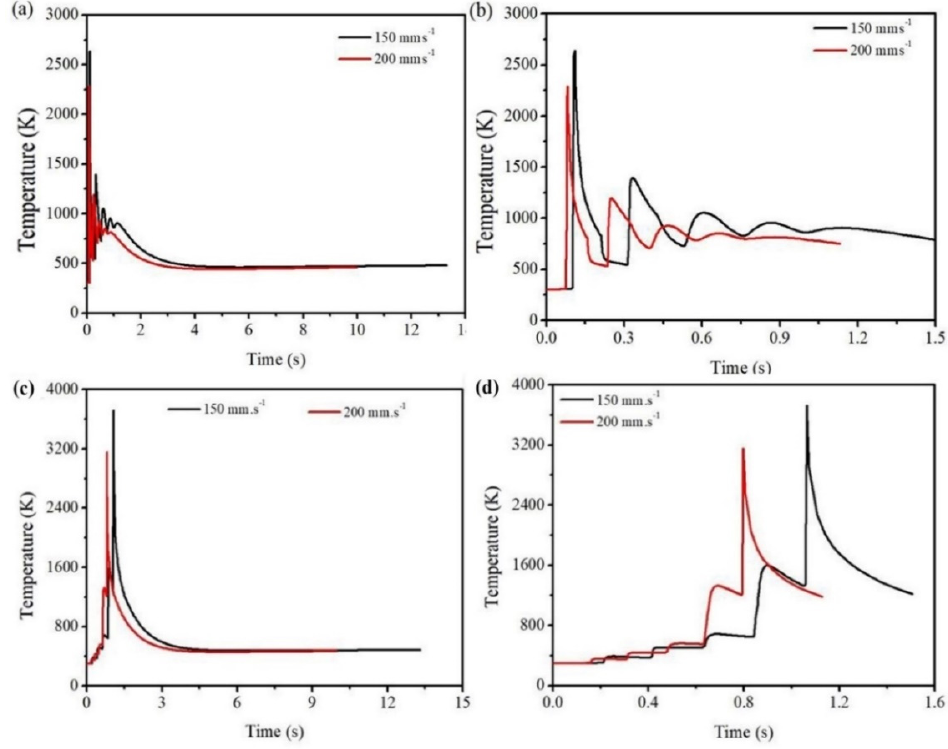
Figure 7. Time-temperature history ( a ) full view, ( b ) zoomed view at the centre of 1st layer, ( c ) full view, ( d ) zoomed view at the end of 5th layer at 200 W laser power and at a scan speed of 150 and 200 mm·s − 1 .